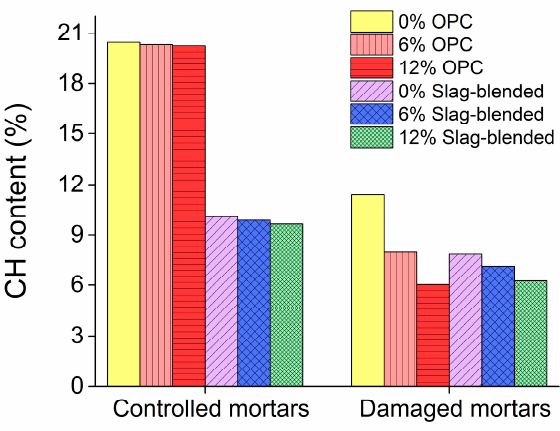
Figure 18. Portlandite content (%) in mortars stored in controlled and aggressive conditions. Materials 2018 , 11 , x FOR PEER REVIEW